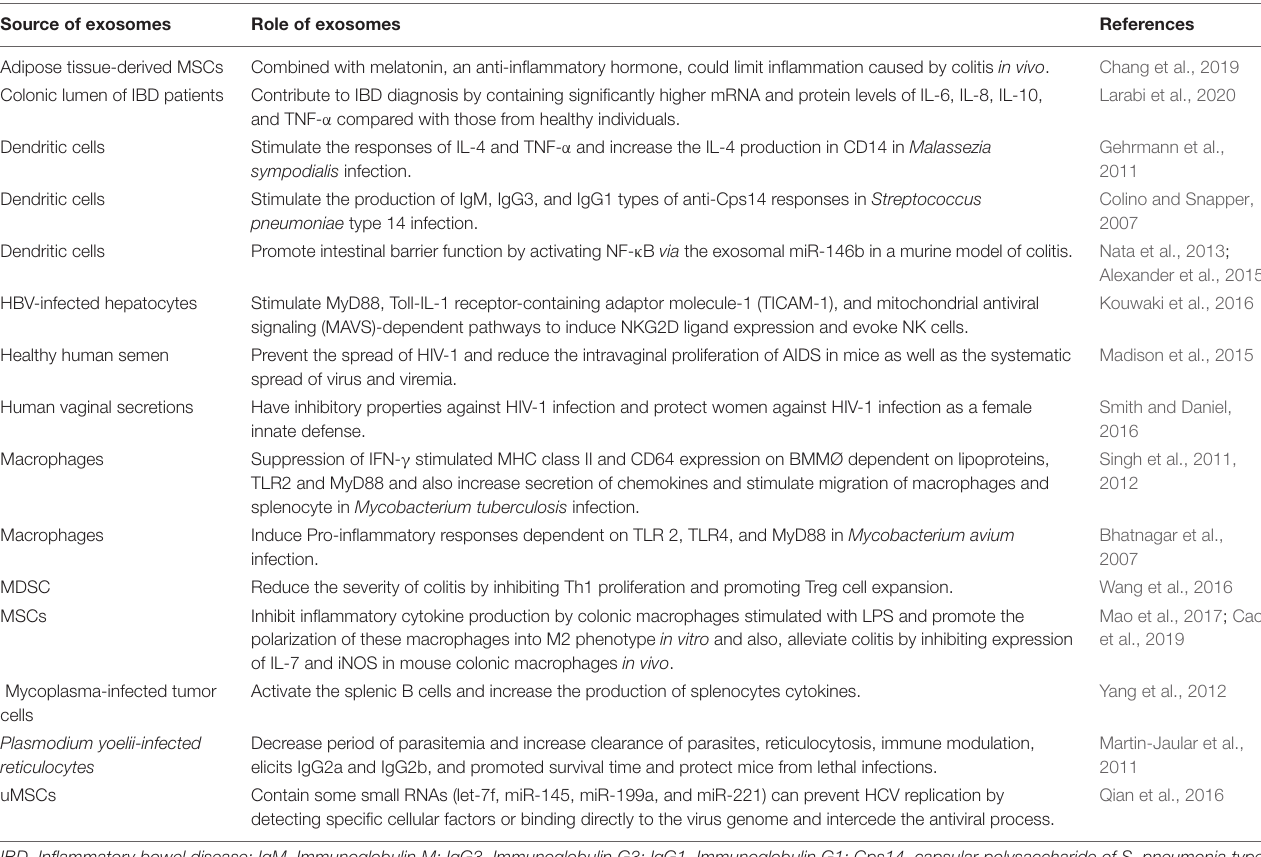
TABLE 2 | The function of different sources of exosomes in infectious